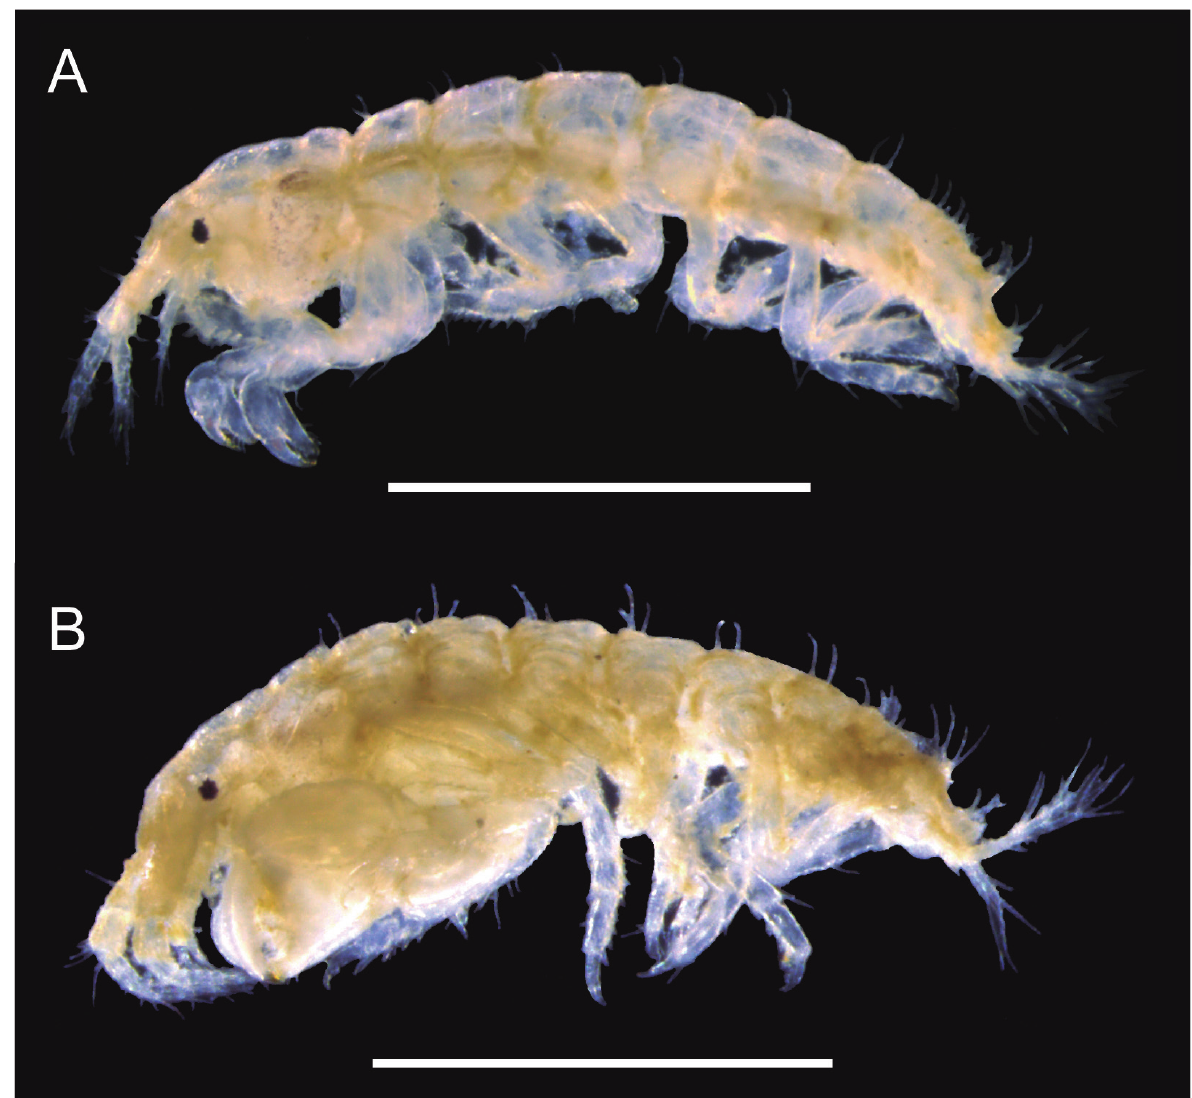
Figure 1. Digital image of Apseudomorpha brasiliensis sp. nov. Paratype female and allotype male (MNRJ 29865 and MNRJ 29864). Female, TL 2.4 mm; Male, TL 1.8 mm. Scale bar: 1.0